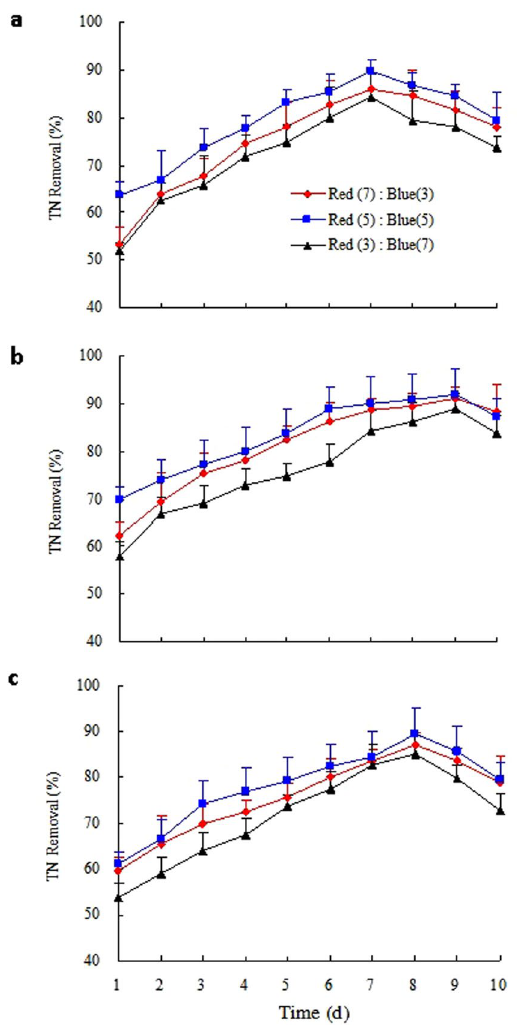
Figure 2. TN removal efficiency over time at cultures 2 under the mixed LED light wavelength treatments for the three selected microalgae species: ( a ) Chlorella vulgaris , ( b ) Scenedesmus obliquus , and ( c ) Nitzschia palea